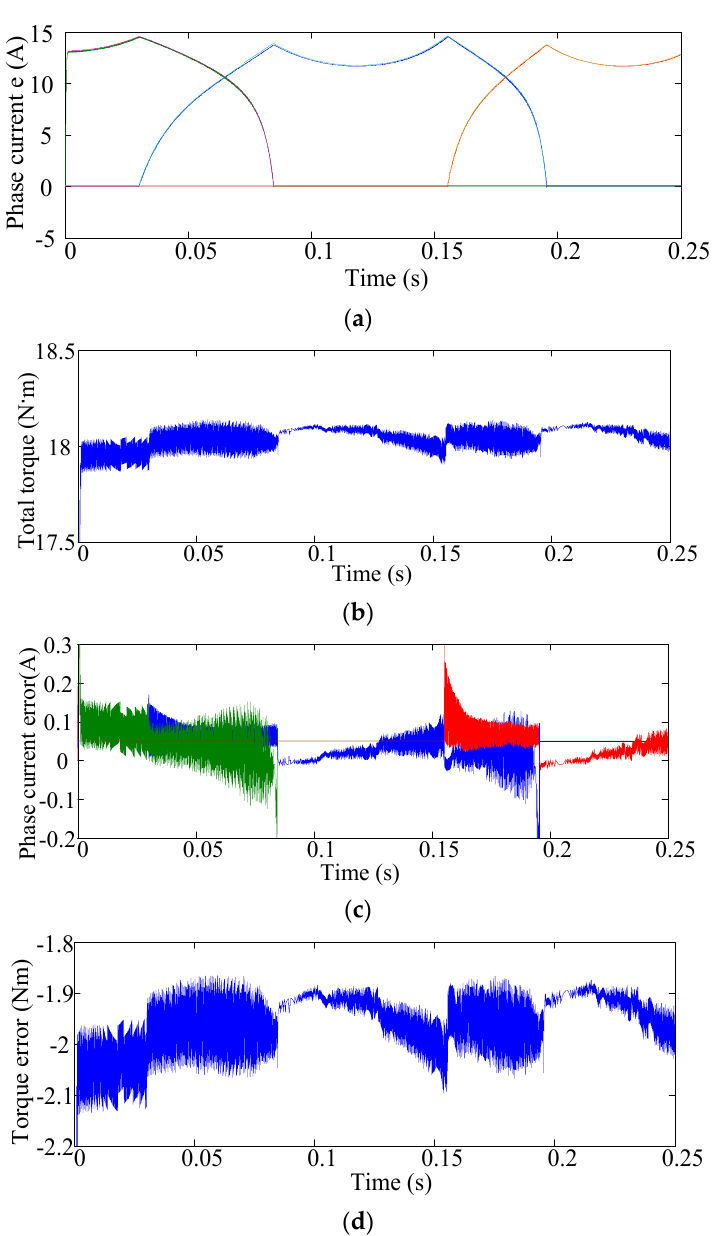
Figure 13. Simulation results when using the predictive current method based on the linear TSF (the reference torque is set to 18 N · m, and the sample time is set to 1 × 10 − 5 s). ( a ) Profiles of the phase (the reference torque is set to 18 N · m, and the sample time is set to 1 × 10 − 5 s). ( a ) Profiles of the phase current and its reference ( b ) total torque, (c) phase current error, and ( d ) torque error. current and its reference ( b ) total torque, ( c ) phase current error, and ( d ) torque